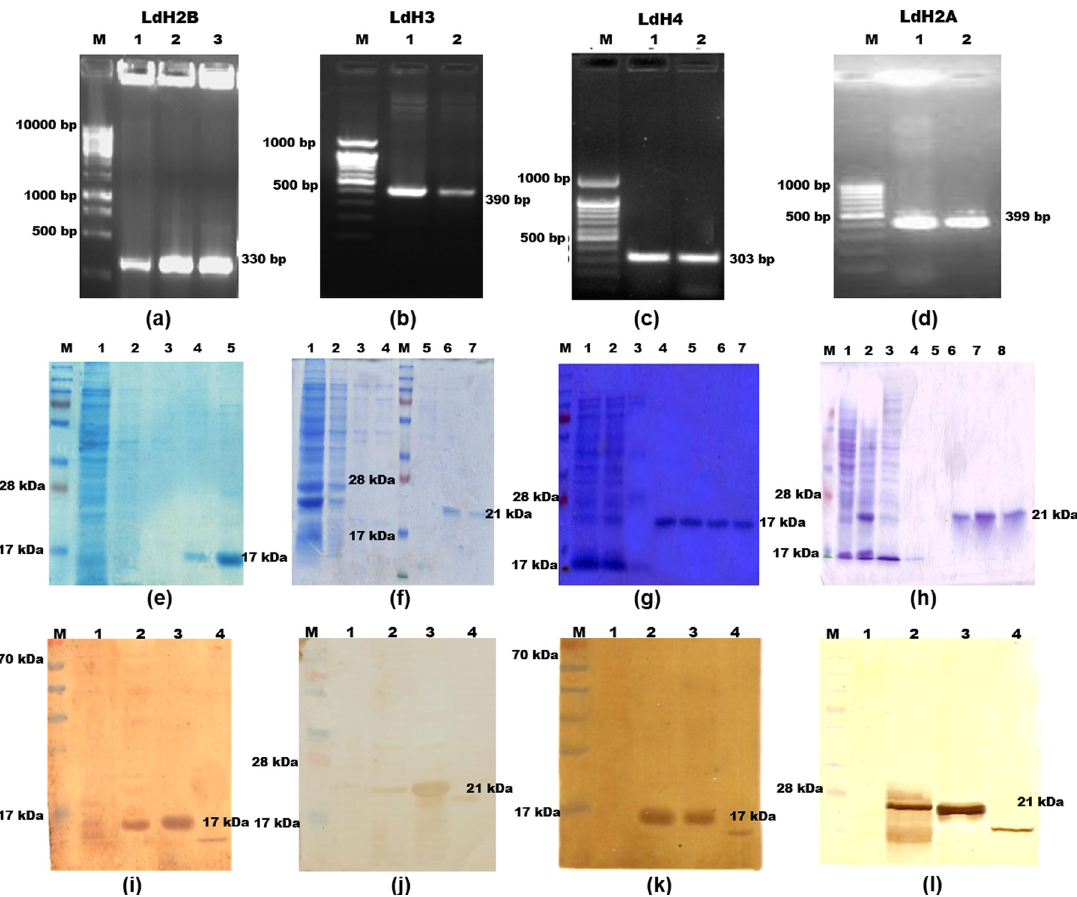
Fig 1. Updated Fig 1. (a,b,c & d)- PCR of of LdH2B, LdH3, LdH4 and LdH2A genes. (e, f, g, & h)- Expression and purification of LdH2B, LdH3, LdH4, LdH2A from E . coli rossetta cells, WCL of transformed E . coli separated on 12% acrylamide gel and stained with Coomassie blue, M: Molecular wt. markers; Lane 1: Flow through; lane 2&3: Washing fraction; Lane 4 & 5: eluted protein. (i, j, k & l)- Western blot analysis using anti-rLhistone antibody in uninduced WCL, induced WCL and leishmania WCL—M: Mol wt marker,